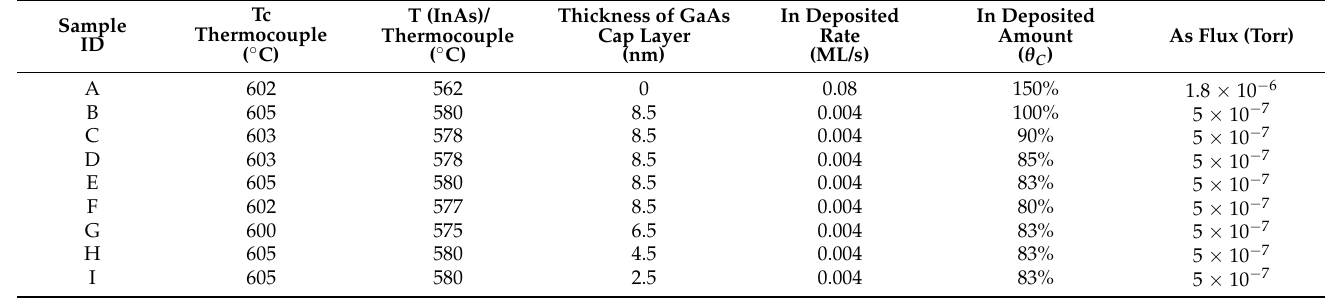
Table 1. List of experimental parameters of investigated samples.